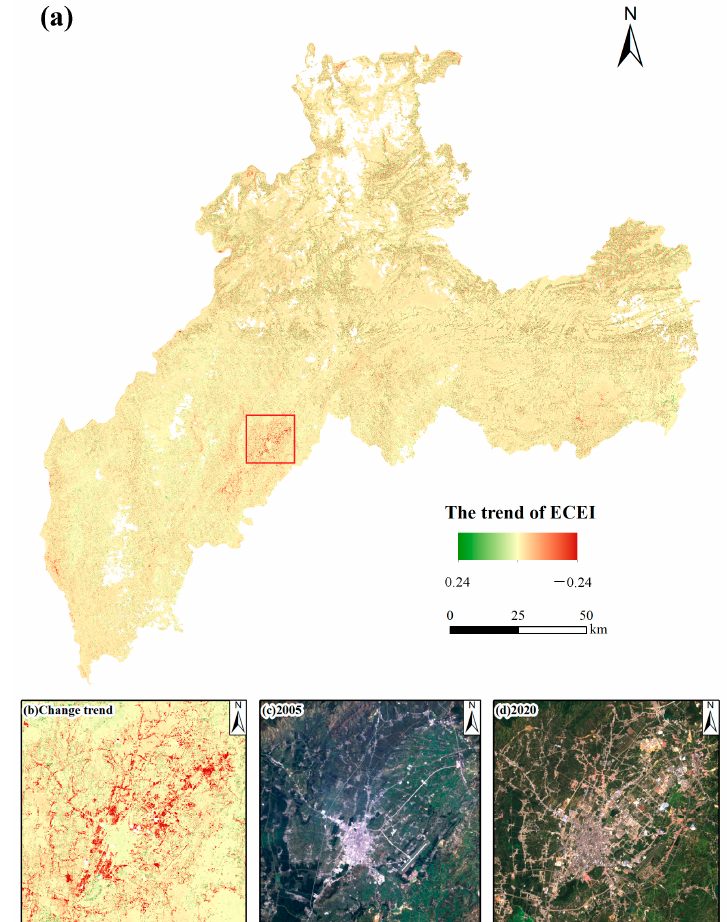
Figure 8. Spatial distribution of the changing trend of ECEI from 2000 to 2020 ( a ), change trend of the selected region ( b ), Landsat image in 2005 ( c ), and Landsat image in 2020 ( d ).